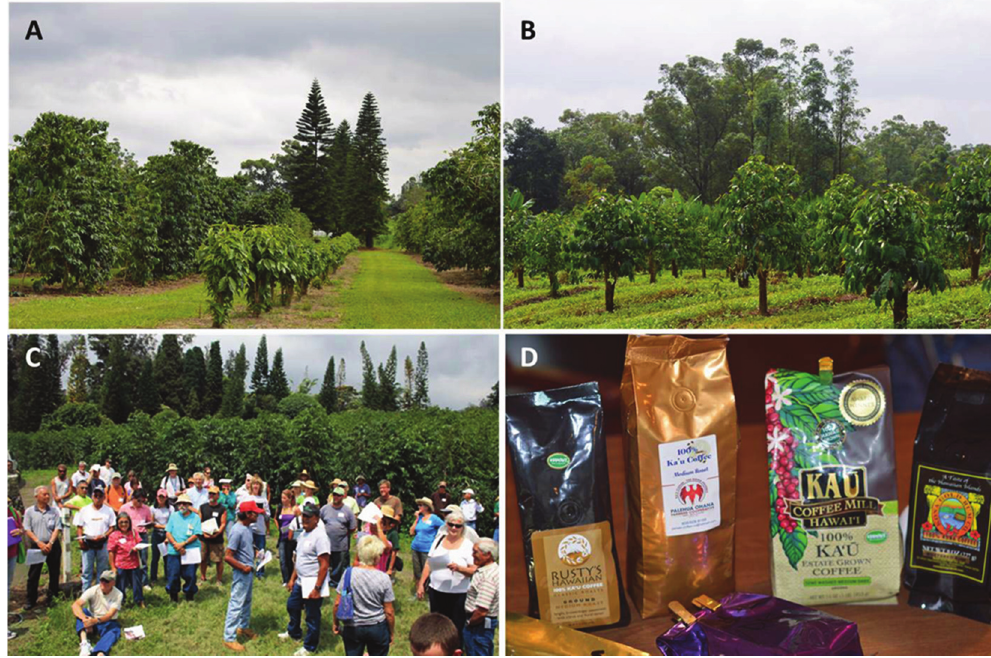
Figure 6. Traditional Kona-style and Beaumont-Fukunaga pruning ( A ); stump pruning by blocks ( B ); training coffee farmers and technicians on IPM ( C ); coffee brands produced in Kau and Kona, Hawaii ( D ). Coffee plantations in Pahala and Kona, Hawaii. Photos taken by Libia C. Mahé and Luis F. Aristizábal.